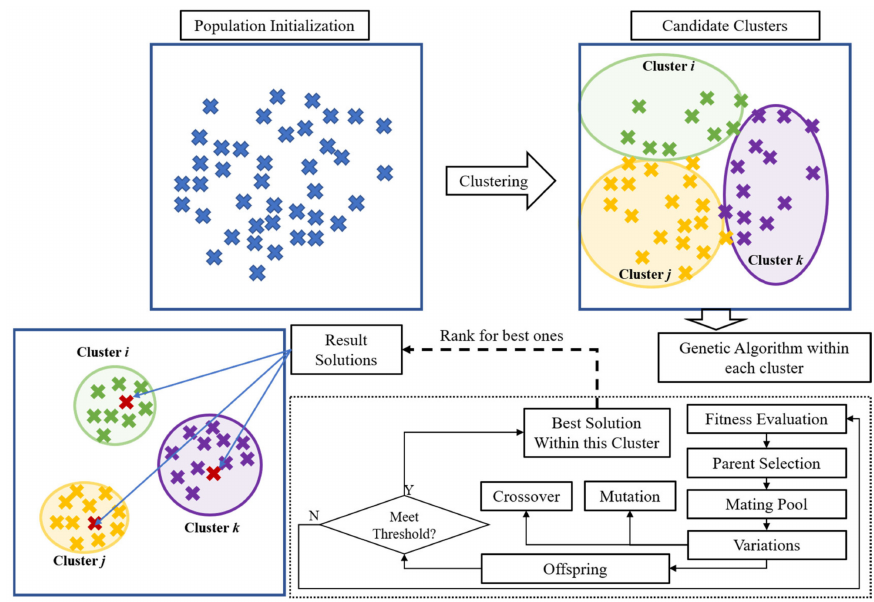
Figure 5. Example of the proposed